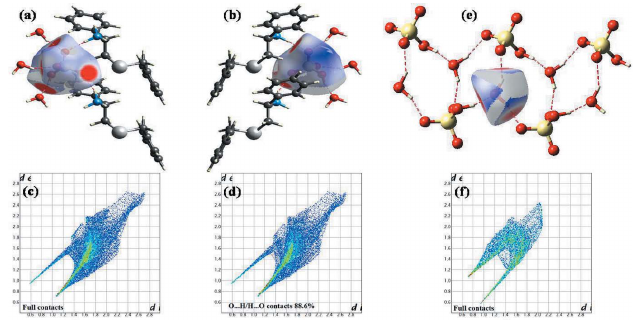
Figure 5 Hirshfeld surfaces: ( a ) and ( b ) two different views of the d norm surface of the anion, ( c ) and ( d ) fingerprint plots of the anion, ( e ) d norm surface and ( f ) fingerprint plot of the water molecule.